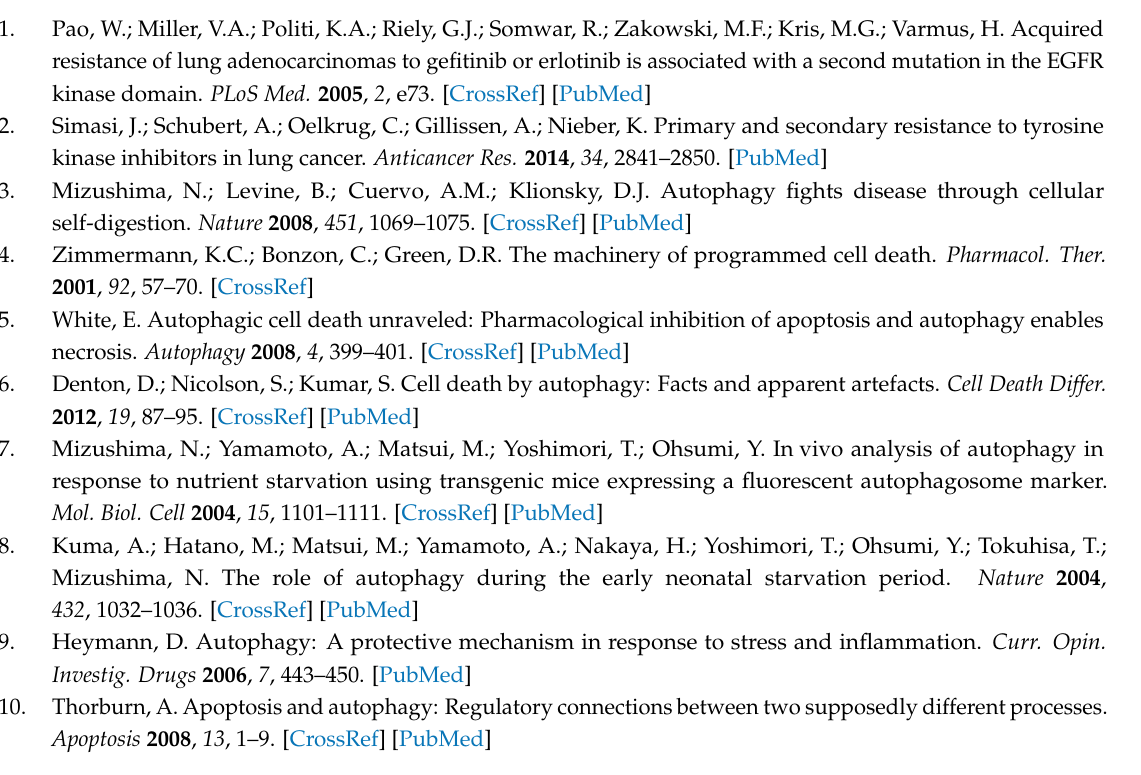
Figure S1: The cell viability determination of normal lung cells with C2-ceramide and CQ